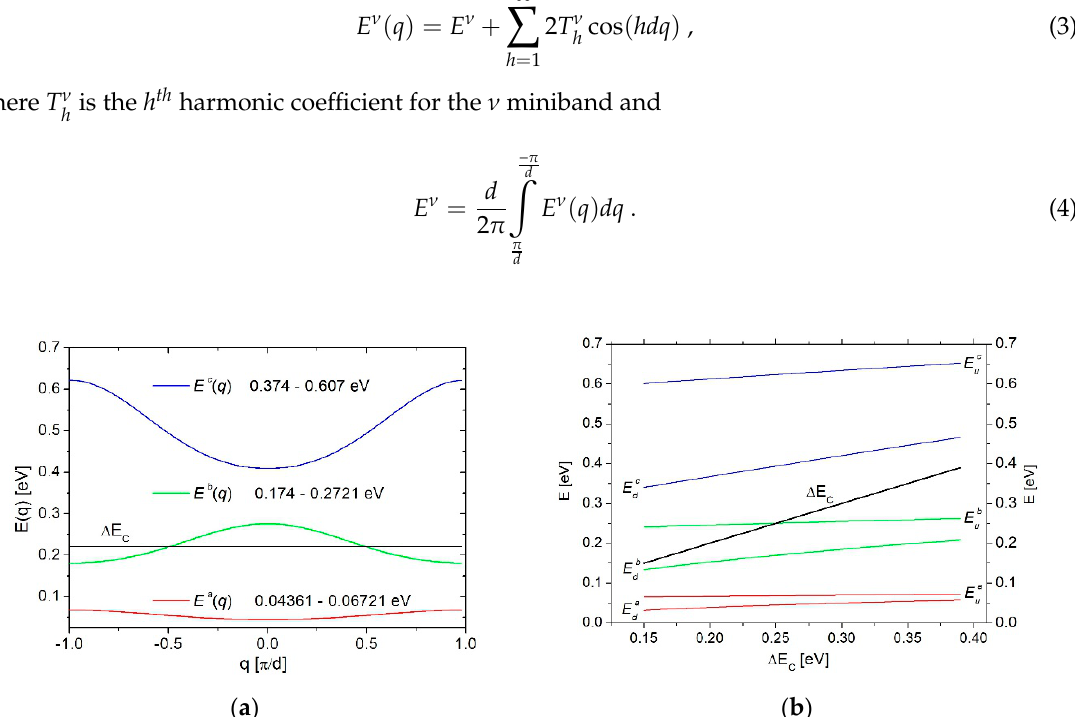
Figure 4. The results of the allowed minibands calculations dedicated to the structure no. 1. described in [17]: ( a ) the dispersion relations E Z ( q ) for the three lowest minibands ( b ) the influence of the discontinuity ( ∆ E C ) on the miniband position in the energy domain.